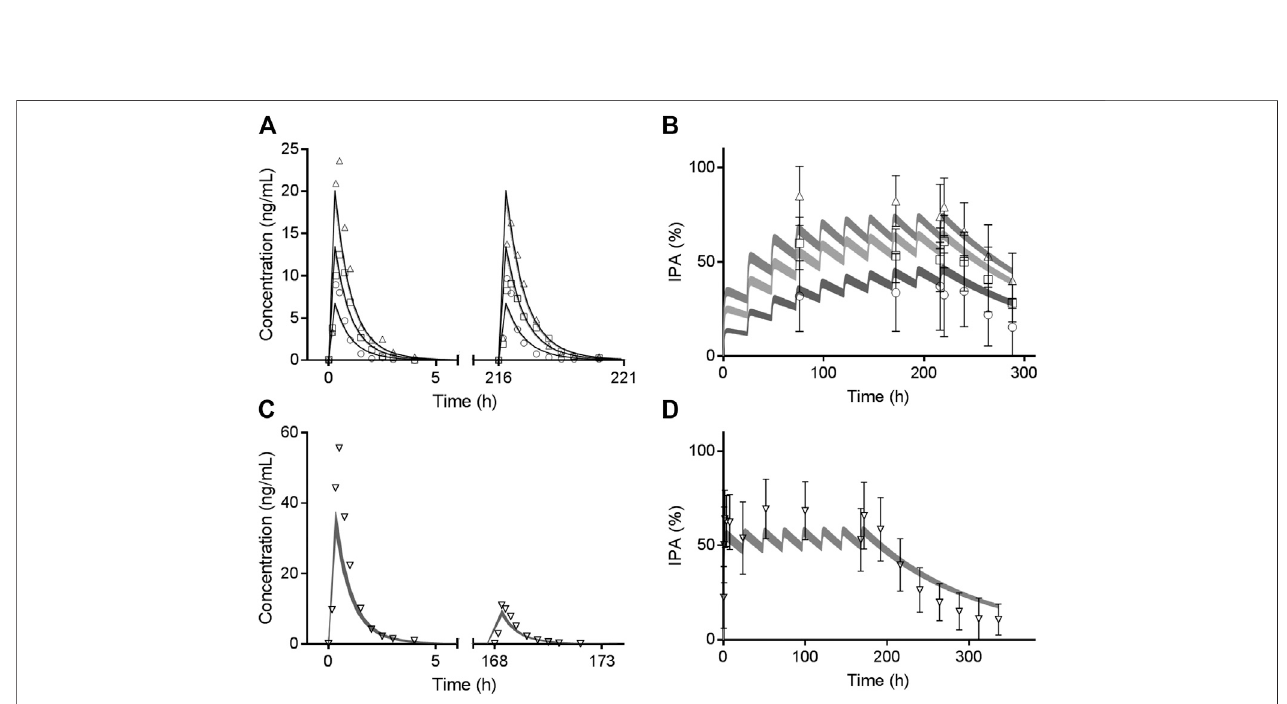
FIGURE 2 | Simulated AM-H4 concentration (left row) and IPA (right row) vs. time of clopidogrel (A and B) and vicagrel (C and D) co-administrated with omeprazole.Dosageregimenswere300 mgLDand75 mg/dayMDfor4daysofclopidogreland24 mgLDand6 mg/dayMDfor4daysofvicagrel,respectively.Bands representsimulated95%con fi denceintervalinthepresence(lightgray)/absence(darkgray)of80 mgomeprazoletreatment. X axiswassetaccordingtothe fi rstdoseof omeprazole.